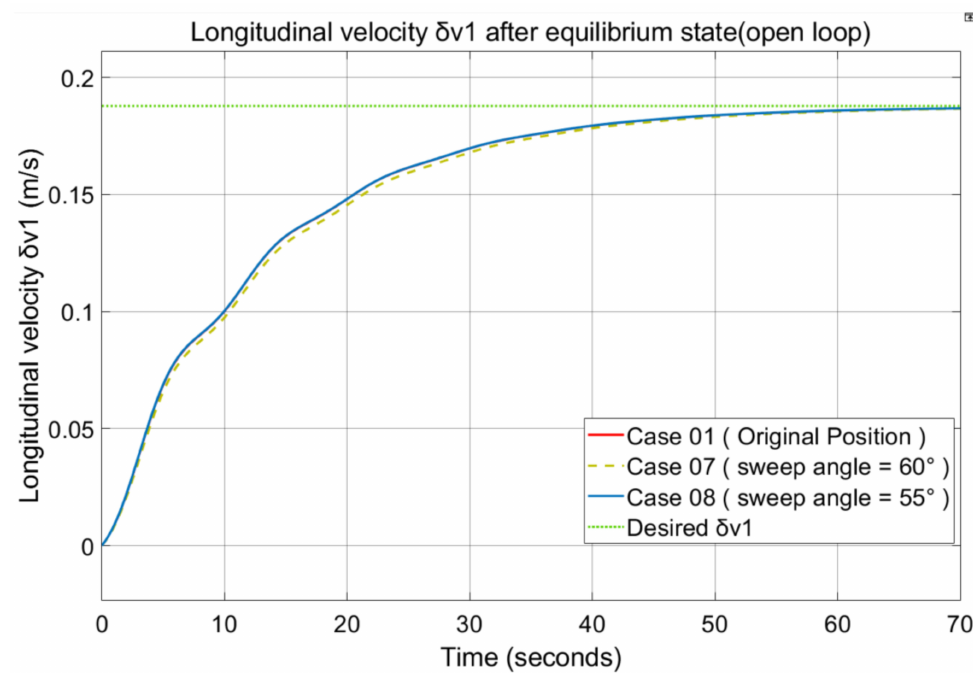
Figure 23. Response of the longitudinal velocity ( δ v 1 ) (open loop) (cases 01, 07 and 08).